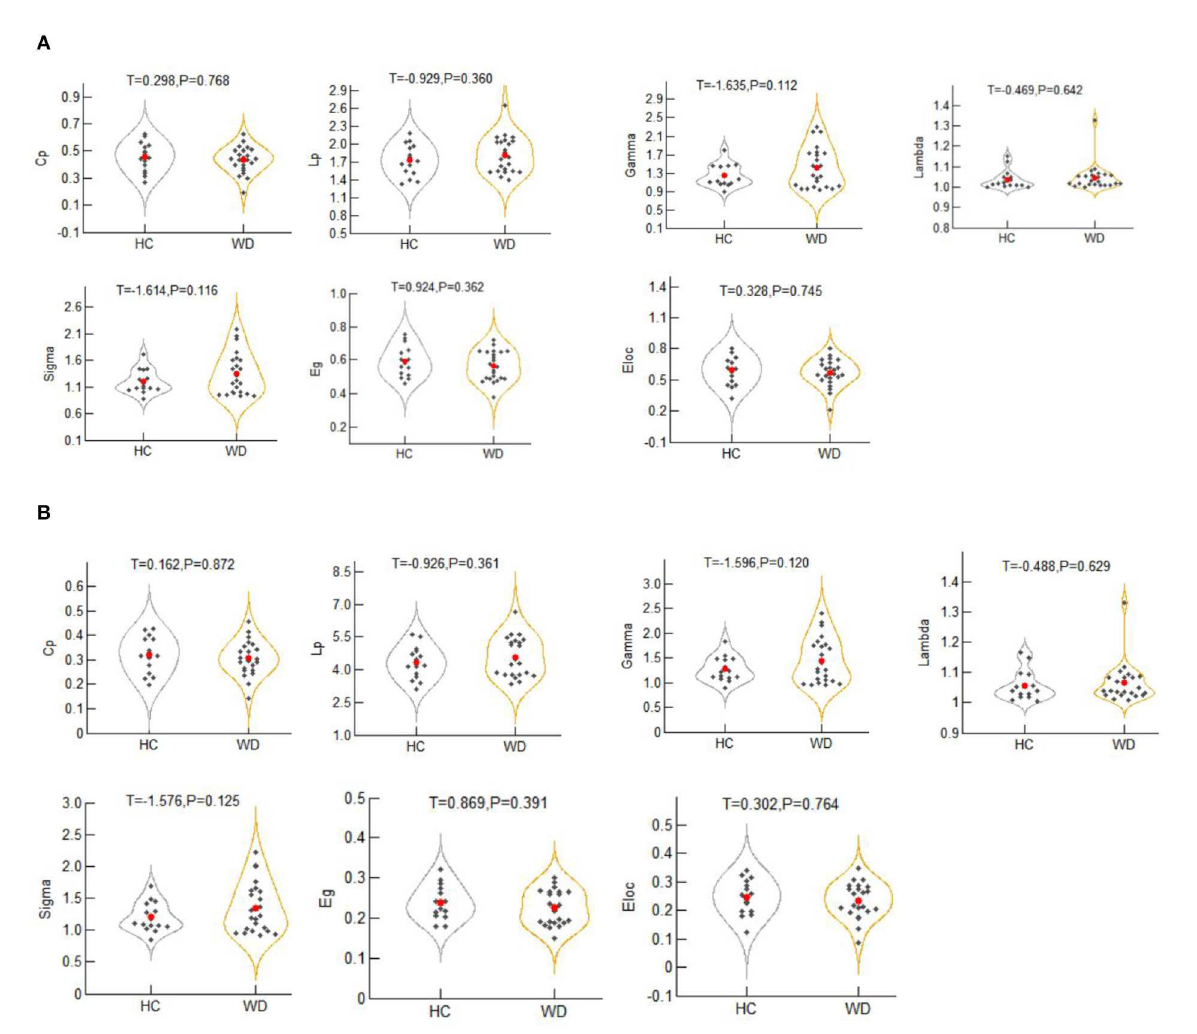
FIGURE2 The global metrics of the binary graphs (A) and weighted graphs (B) of the motor execution network in Wilson’s disease patients and healthy controls. Error bars represent standard errors. Cp, clustering coefficient; Lp, characteristic path length; Gamma, normalized clustering coefficient; Lambda, normalized characteristic path length; Sigma, small-worldness; Eloc, local efficiency; Eg, global efficiency; HC, healthy controls; WD, Wilson’s disease